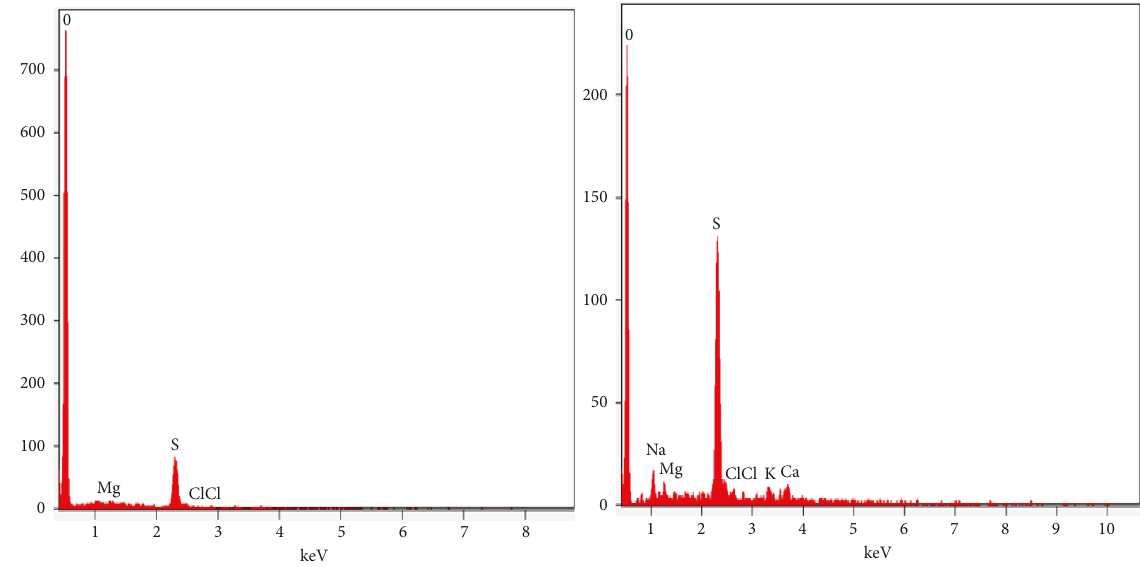
Figure 3: EDX spectrum for 1 and 2mol% of MgCl